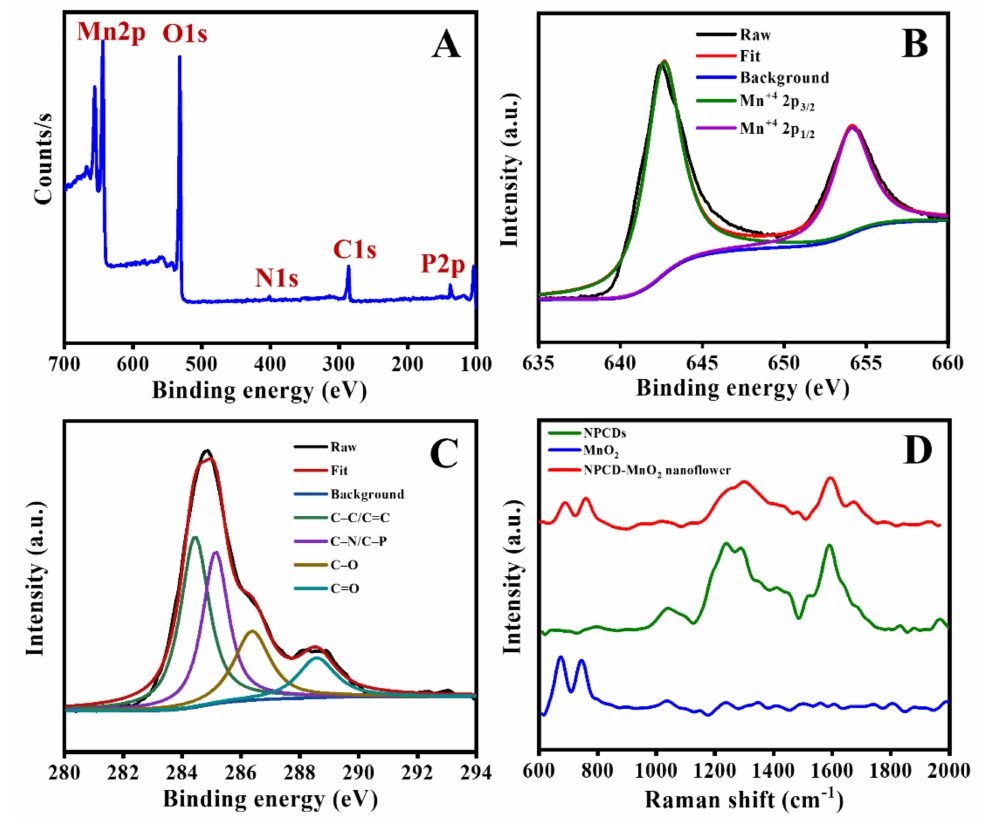
Figure 4. ( A ) XPS element survey of the NPCD-MnO 2 nanocoral composite. High-resolution XPS spectra of ( B ) Mn2p and ( C ) C1s. ( D ) Raman spectra of the NPCDs, MnO 2 , and NPCD-MnO 2 nanocoral